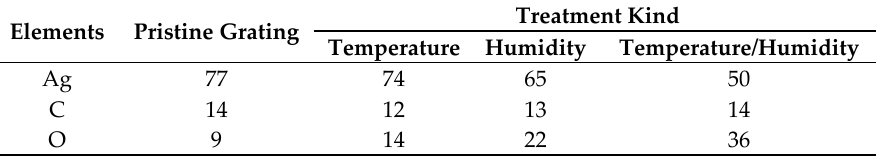
Table 1. XPS measured surface elements